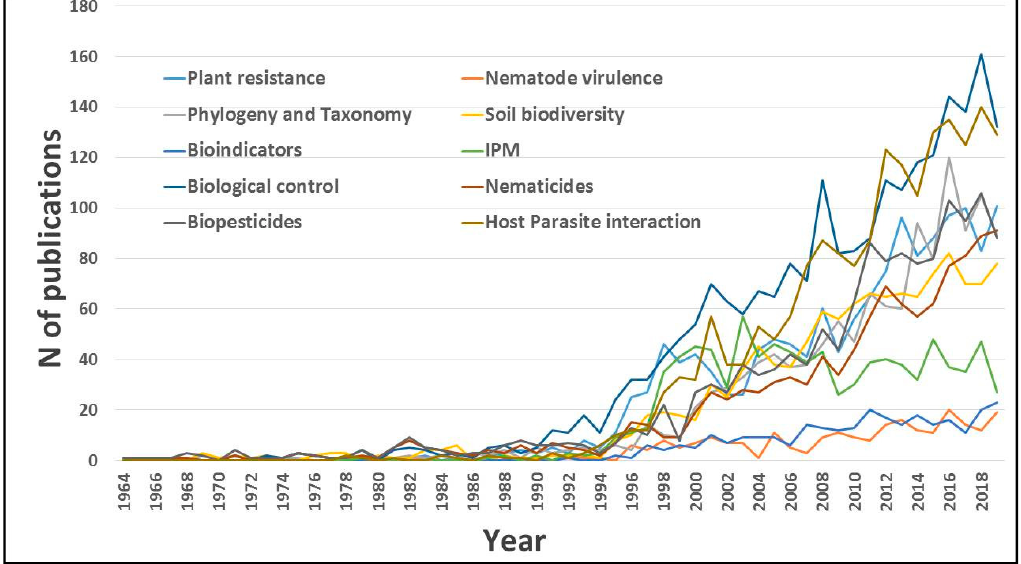
Figure 6. Relationship between the main types of crops and the species of nematodes more present in scientific literature according the keywords.